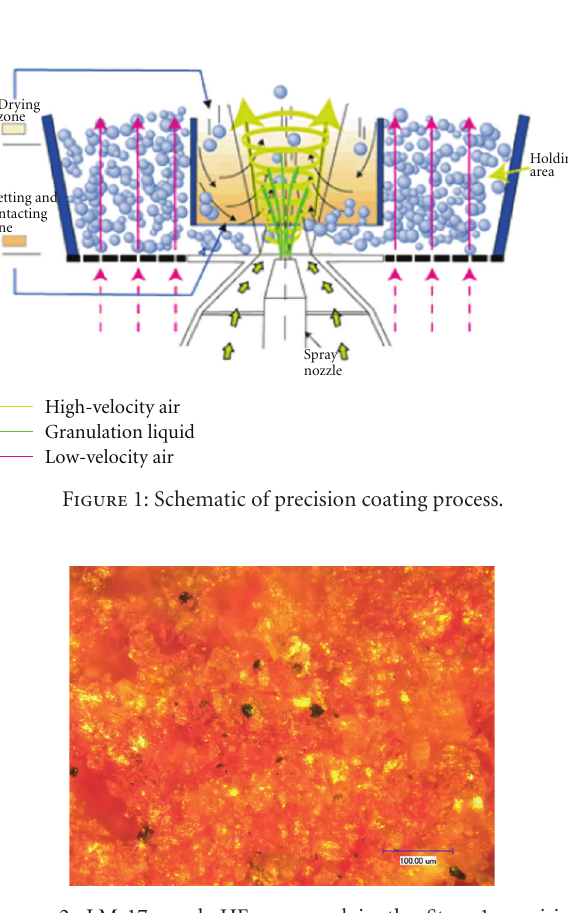
Figure 2: LM-17 mock HE processed in the Strea-1 precision coater.